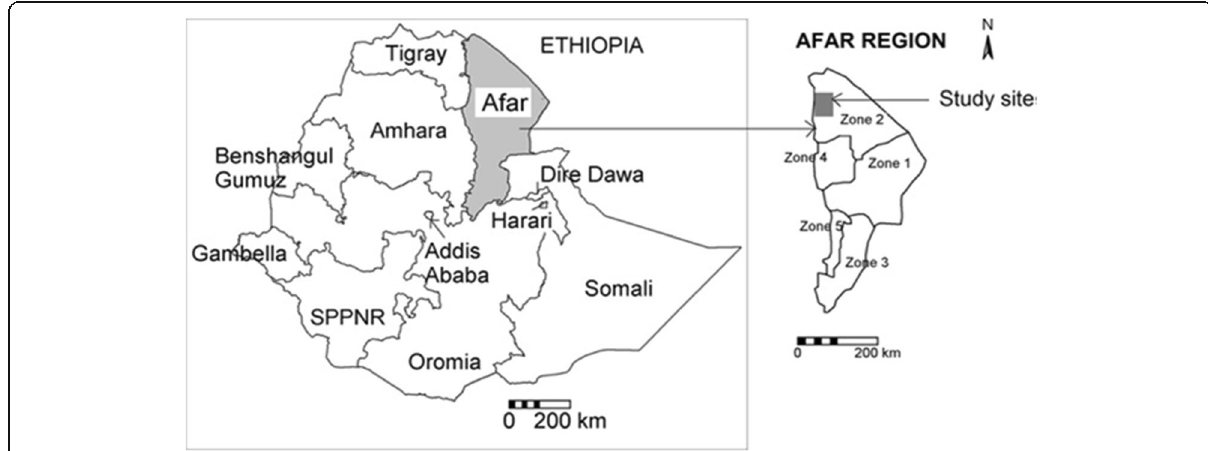
Fig. 2 The location of the study is the Aba ’ ala district, relative to the Afar regional State, zones within the Regional State and